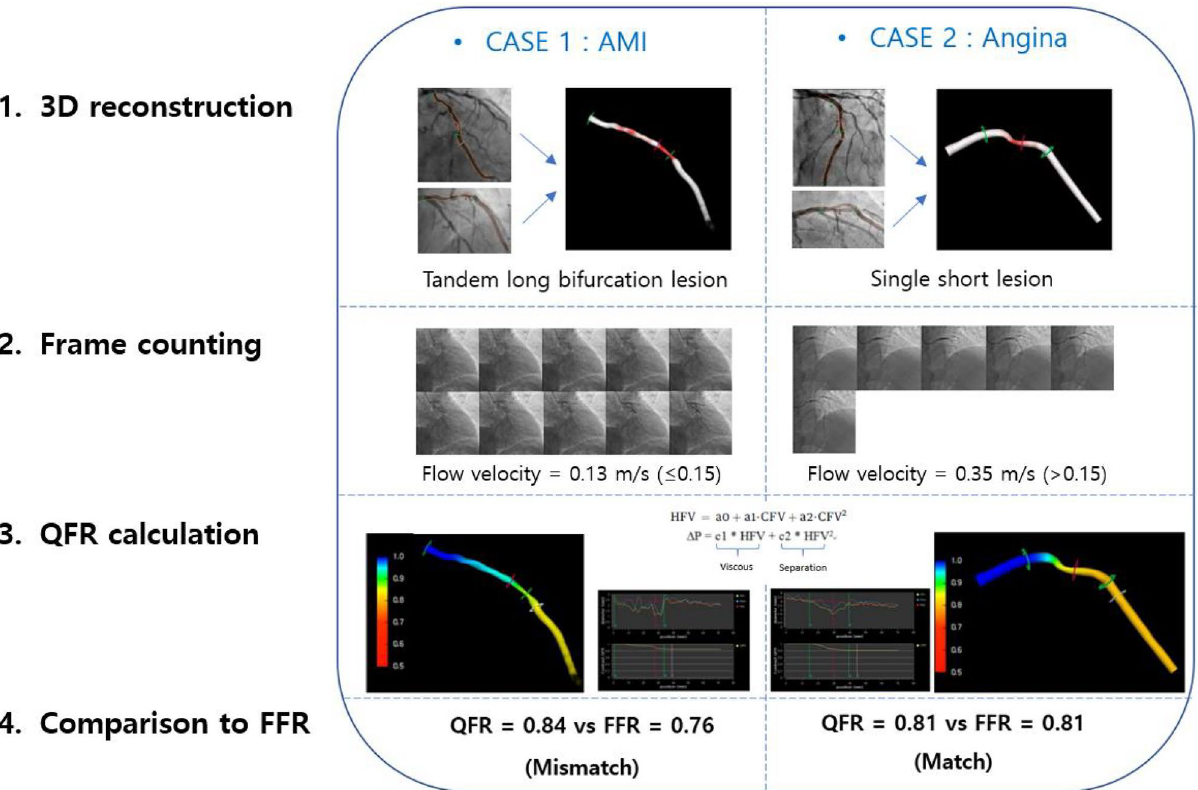
Figure 5. Computation of QFR by coronary angiography in 2 representative QFR-FFR mismatched and matched cases. Case 1: The calculated QFR value in a noninfarct-related artery accompanying lesions with multiple complexities was mismatched with the FFR. Case 2: The calculated QFR for a vessel in a patient with angina accompanying a simple lesion was exactly matched with the FFR. The QFR analysis images were extracted with QAngio XA 3D/QFR, V 1.2 by Medis Medical Imaging, Leiden, The